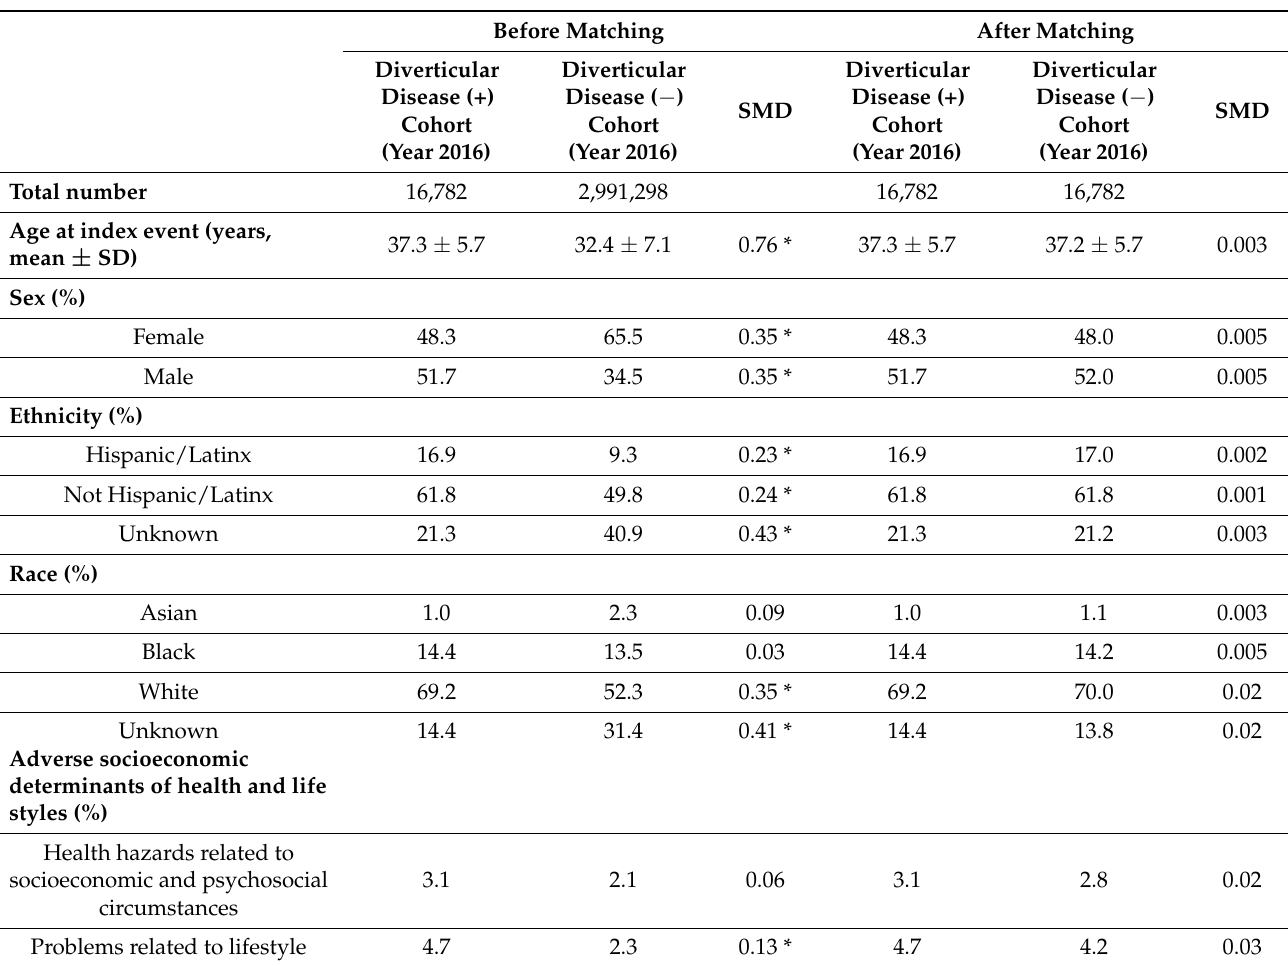
Before Matching After